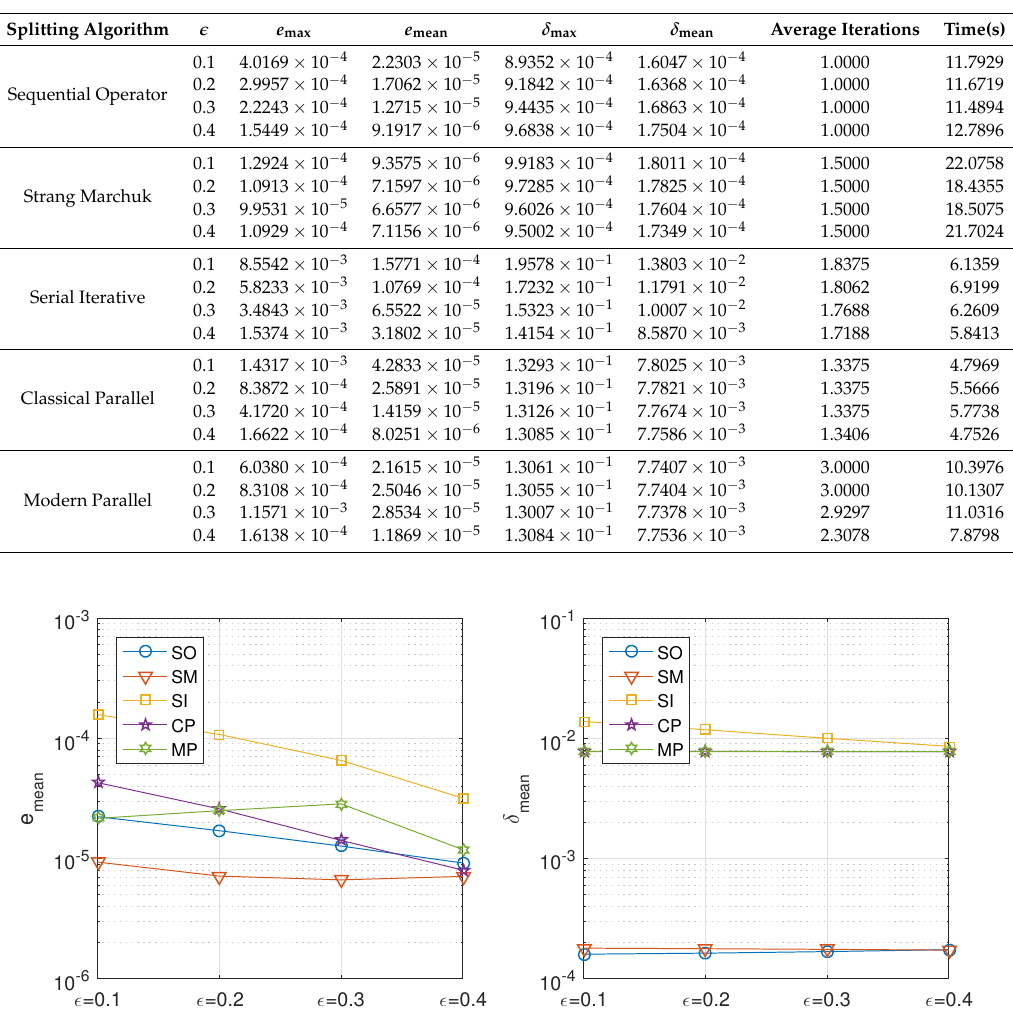
Figure 19. Fractional diffusion equation, mixed decomposition. Precision of the proposed methods: sequential iterative SI, classical parallel CP, and modern parallel MP, compared with the classical ones: sequential operator SO and Strang–Marchuk SM, for 20 temporal steps, 320 temporal steps, and different values of (cid:101)